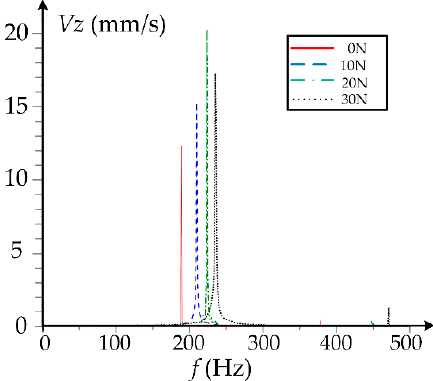
Figure 9. The bearing vibration under different radial loads when L = 1.7.